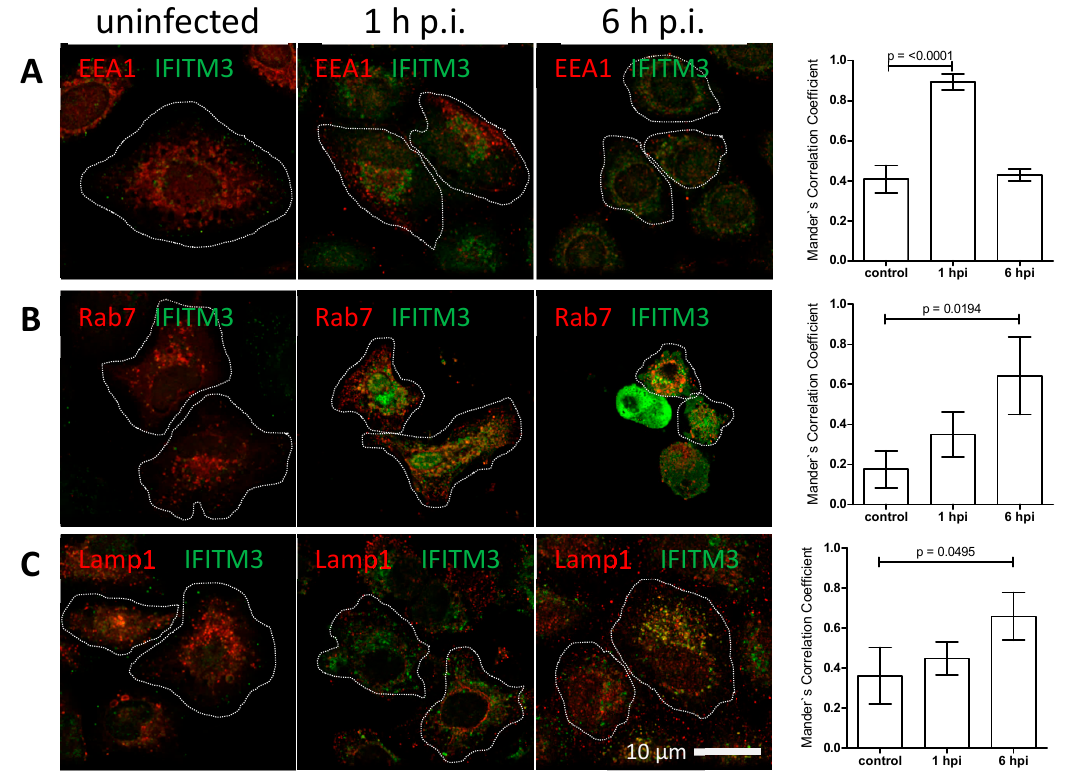
Figure 6. The co-localization of IFITM3 proteins with early and late endosomes and lysosomes. A549 cells were infected with influenza A virus (IAV) A / Hong Kong / 1 / 1968 (MOI = 1) and fixed with ice cold methanol at the indicated time points. The indirect immunofluorescence analysis using anti-IFITM3 (green) in combination with ( A ) anti-EEA1 (red), ( B ) anti-Rab7 (red) and ( C ) anti-Lamp1 (red). The images show the merged acquisition channels. The periphery of the immunostained cells was outlined with white dotted lines on the basis of the cell morphology. The image acquisition was performed using a 60 nm ( = confocal mode) pixel size. (right panel) The signal intensities for IFITM3 were correlated with ( A , B ) endosomal and ( C ) lysosomal markers. Mander’s Correlation Coefficients from three independent experiments for each condition were calculated using the coloc2 plugin implemented in Fiji software. The mean values are plotted with the mean (SD).